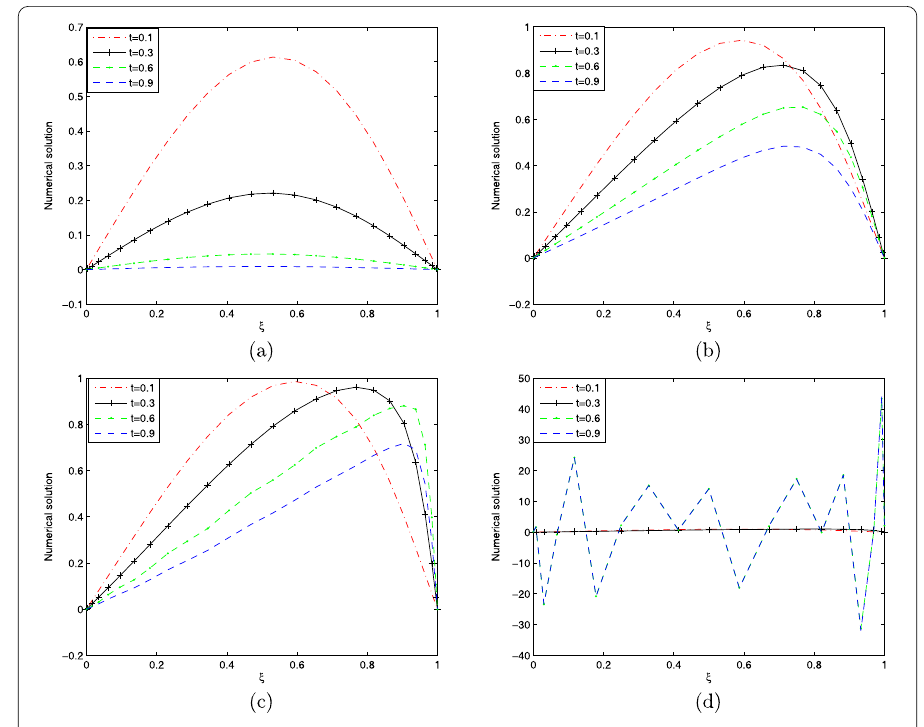
Figure 1 Approximate solutions of Example 3: ( a ) solution of β = 2 –1 with ρ ( M ) < 1, ( b ) solution of β = 2 –4 with ρ ( M ) < 1, ( c ) solution of β = 2 –6 with ρ ( M ) < 1, and ( d ) solution of β = 2 –9 with ρ ( M ) >